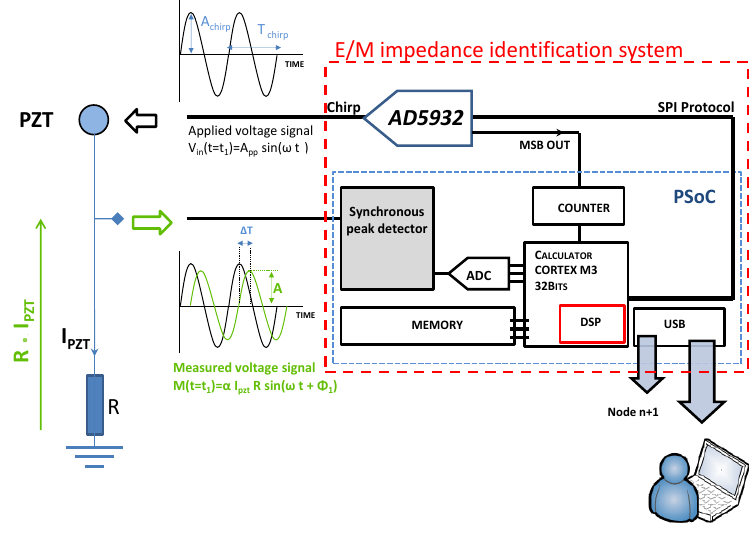
Figure 10. Synoptic of the developed E/M impedance calculation technique. Note that R is equal to 10 Ω; ΔT is the time delay between the excitation signal and the sensor